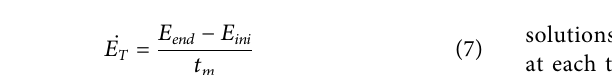
Frontiers in Energy Research |